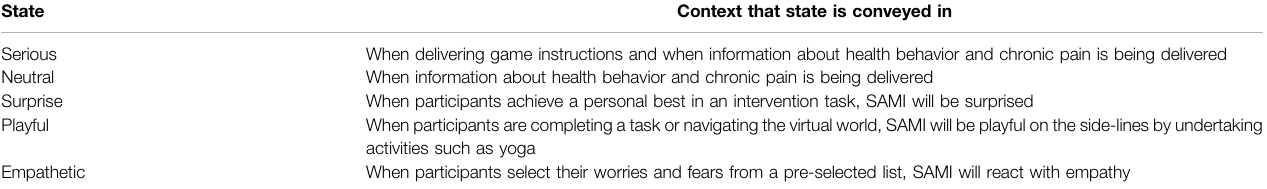
TABLE 1 | The fi ve main states that are conveyed by SAMI. State Context that state is conveyed in